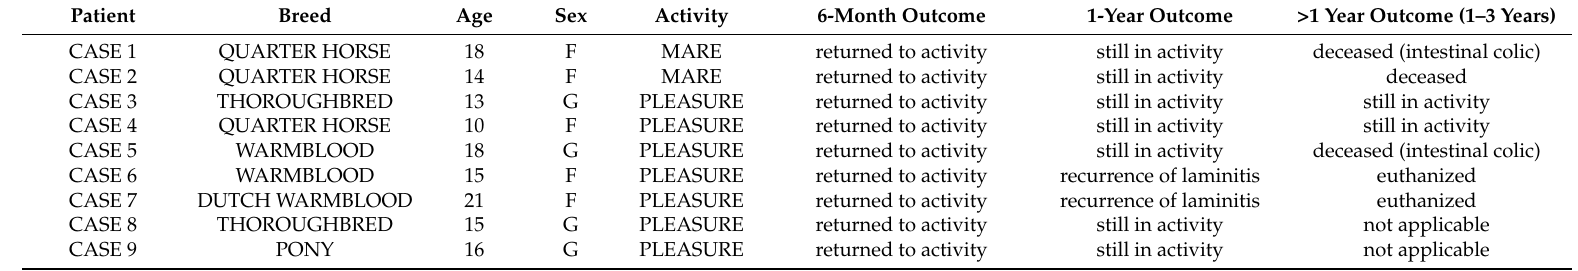
Table 2. Long term outcome of therapy for laminitic horses following aMSC and platelet-rich plasma (PRP) treatment. Legend: F = female, G = gelding. Patient CASE